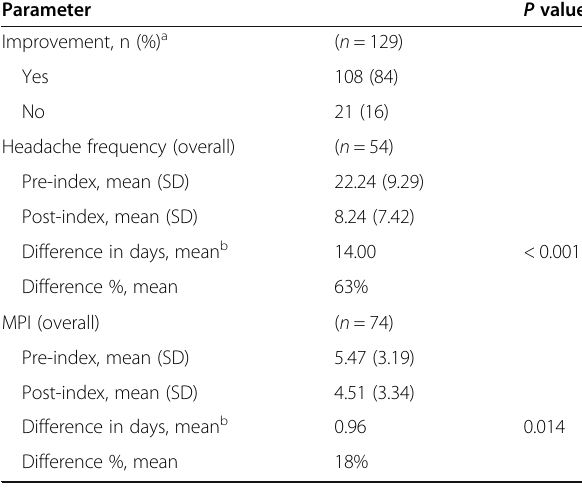
Table 2 Patient comorbidities in the pre-index period Comorbidities, n (%)